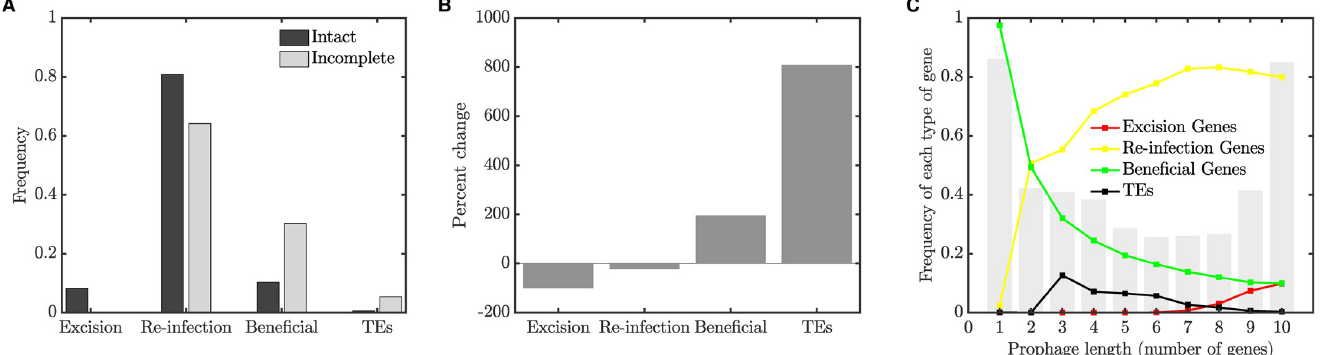
Fig 7. Gene frequencies in intact and incomplete prophages, when TEs are included. (A) Frequency of genes of each type in intact and incomplete prophages, for the computational model simulated at the persistence equilibrium with TE disruptions (see text for details). (B) Percent change in gene frequency from intact to incomplete. (C) A histogram of prophage lengths (grey bars), as well as the frequency of gene classes at each length. We find a bimodal distribution of prophage sizes, with TEs accumulating in prophages of intermediate lengths. In all cases r S = 1.5, r L = 1.5, r D = 0.05 and r T = 0.002. A population of 10,000 prophages was simulated for 20,000